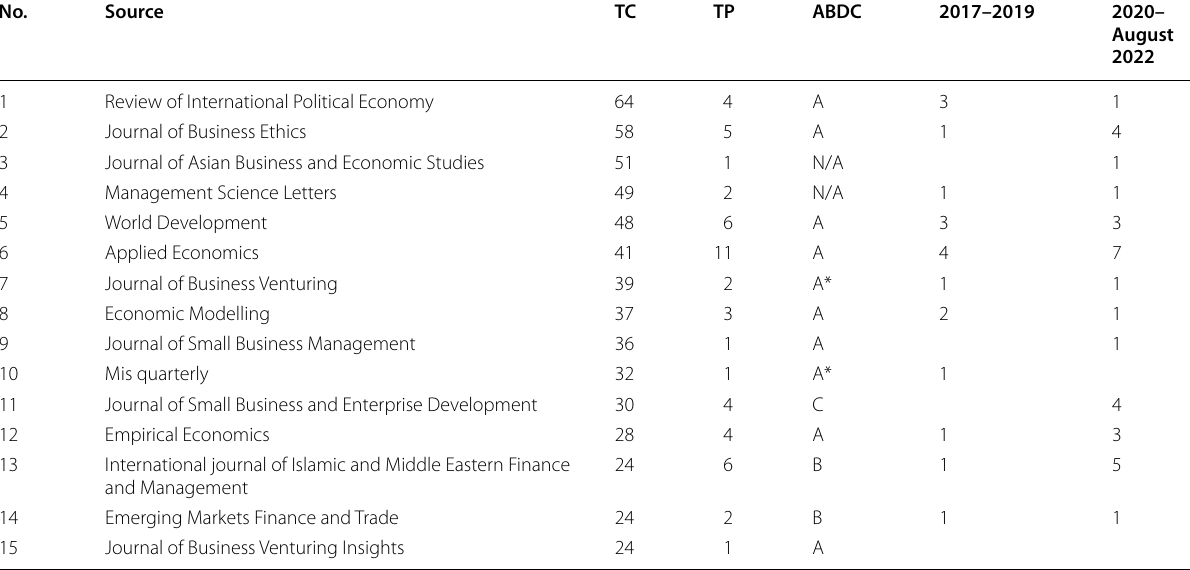
Table 4 Most cited journals for topics in microfinance and microfinance institutions No. Source